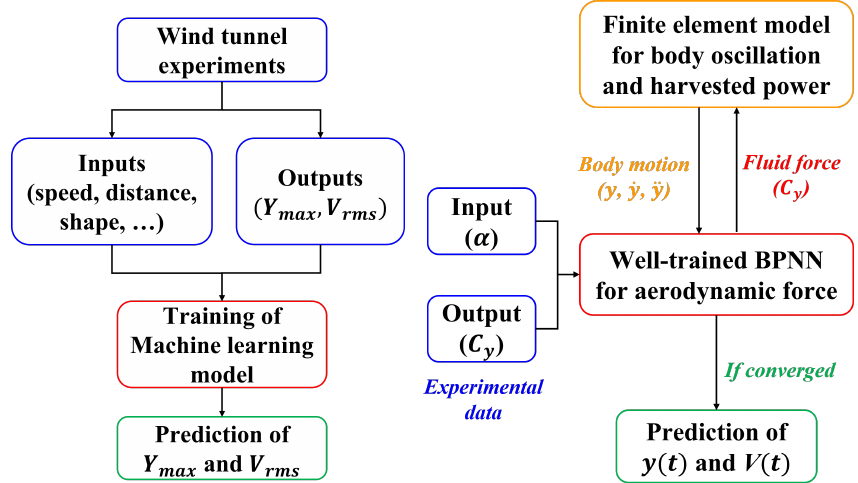
Figure 14. Machine-learning modelling procedure for a piezoelectric energy harvester based on wake galloping [267] ( left panel ) and galloping [268] ( right panel